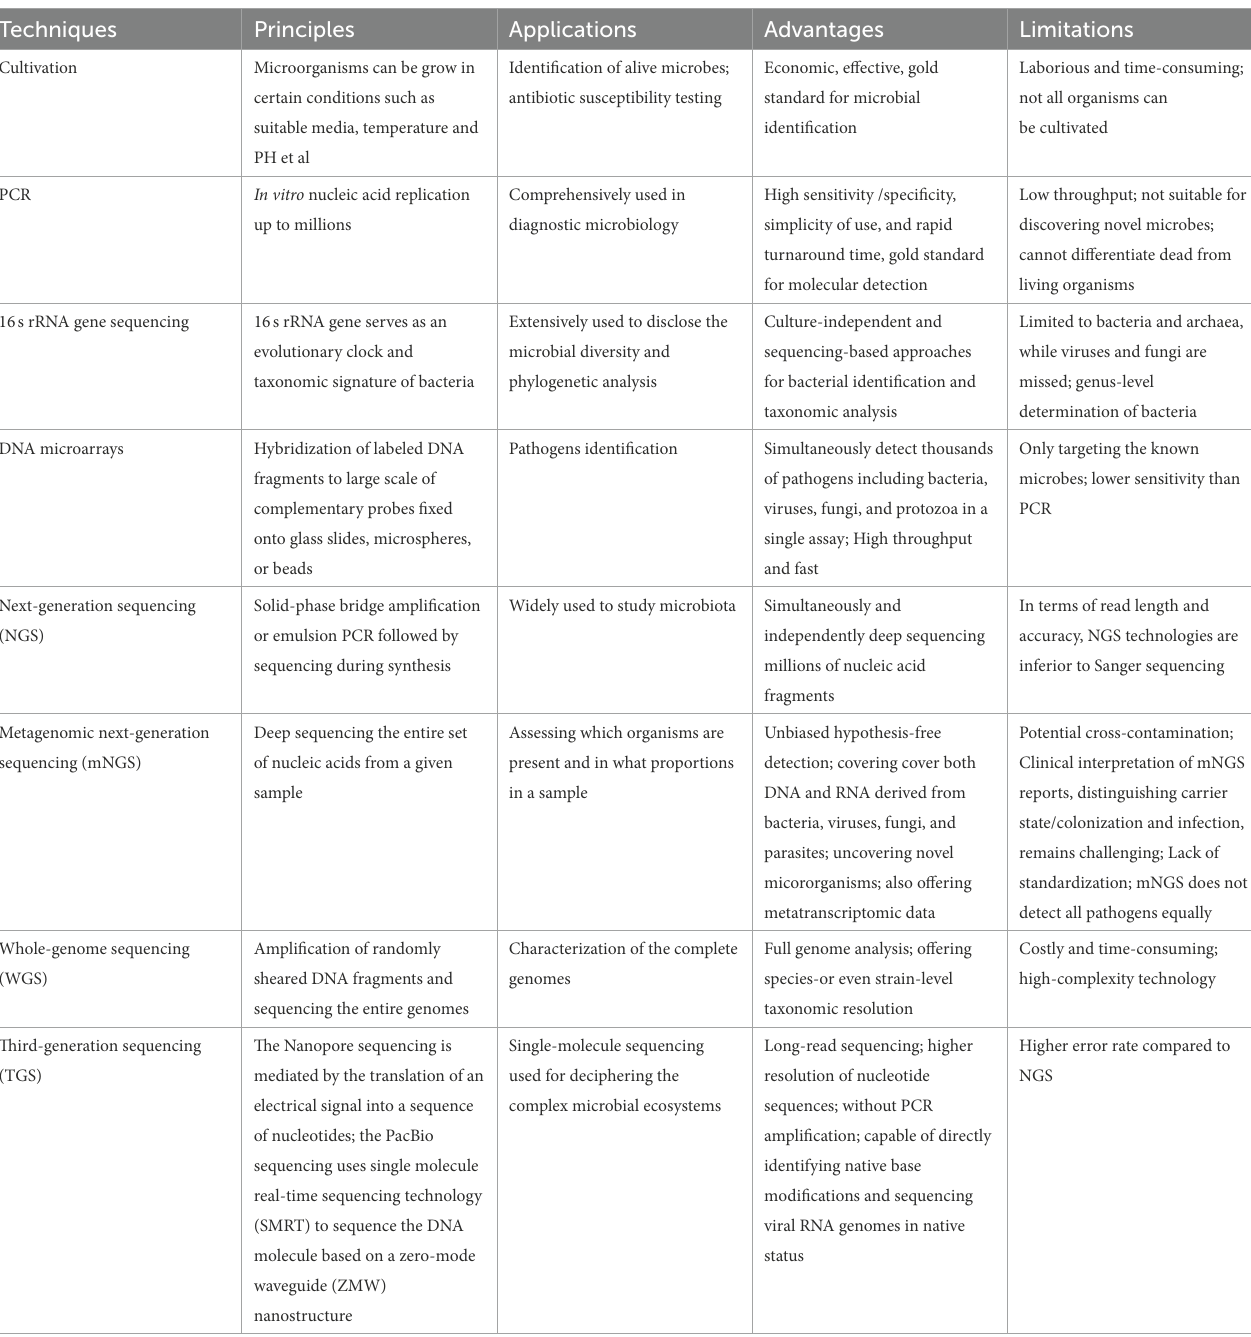
TABLE 1 Various techniques used for identifying oral